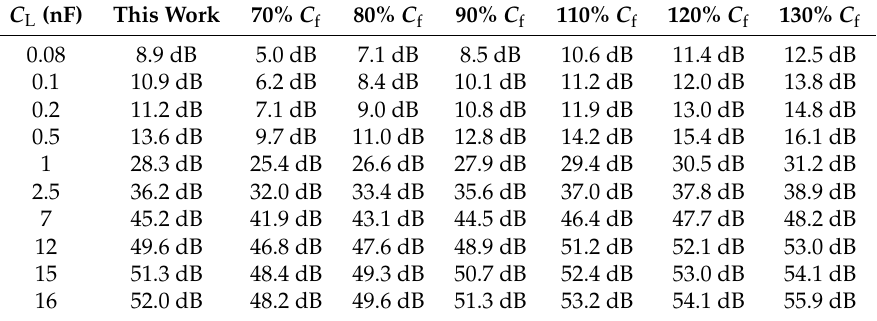
Figure 10. Simulated gain margin of the proposed amplifier with 0.05–17 nF load capacitance over Miller compensation capacitance variations. Table 5. Gain margin over variations on Miller compensation